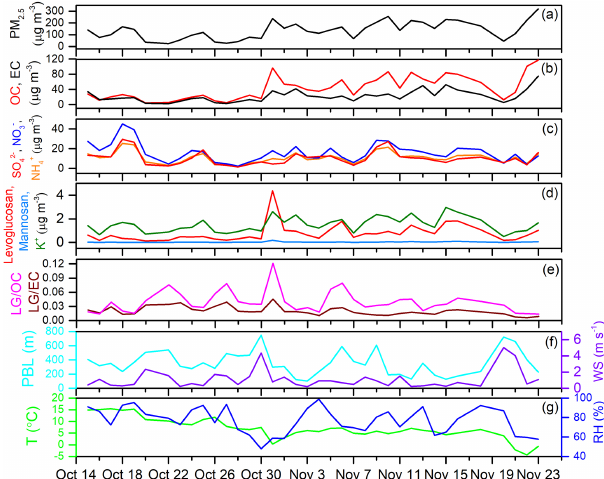
Figure 1. Time-series variation obtained for PM 2.5-cal and its ma- jor components, biomass burning tracers and meteorological fac- tors at the GC site during the sampling period from 15 October to 23 November 2016. (a) PM 2.5-cal , (b) OC and EC, (c) secondary inorganic aerosols, i.e., SO 2 − , NO − and NH + , (d) levoglucosan, 4 3 4 mannosan and K + , (e) ratios of levoglucosan to OC (LG / OC) and levoglucosan to EC (LG / EC), (f) PBL and wind speed (WS), (g) temperature ( T ) and relative humidity